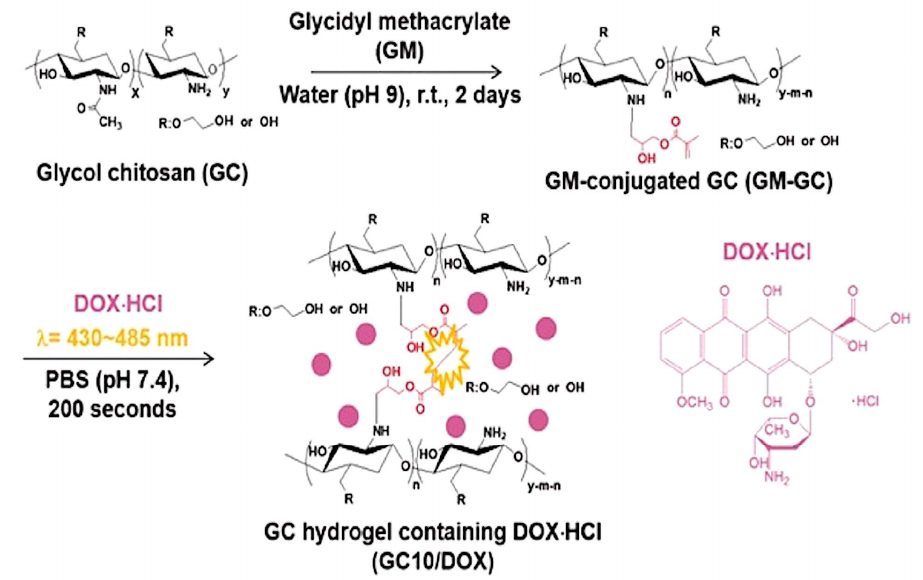
Figure 7. To glycol chitosan solution glycidyl methacrylate (GM) was added in water (adjusted to pH 9) and maintained for 2 days at room temperature. The white solid conjugate of GM was dissolved in water and riboflavin added. DOX · HCl was added and the mixture was irradiated using blue visible light (430–485 nm, 2100 mW/cm 2 ) for 10 minutes in order to promote hydrogelation